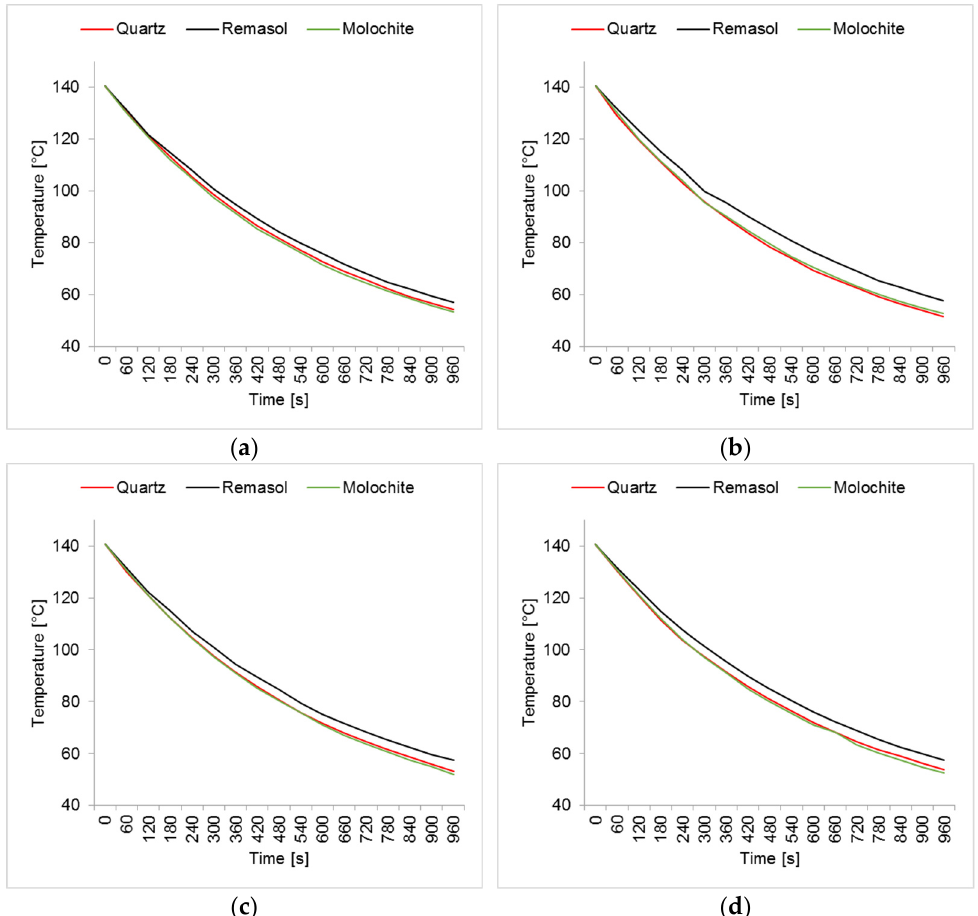
Figure 15. Temperature drop of the ceramic samples depending on the time: ( a ) first site, ( b ) second site, ( c ) third site and ( d ) fourth site.